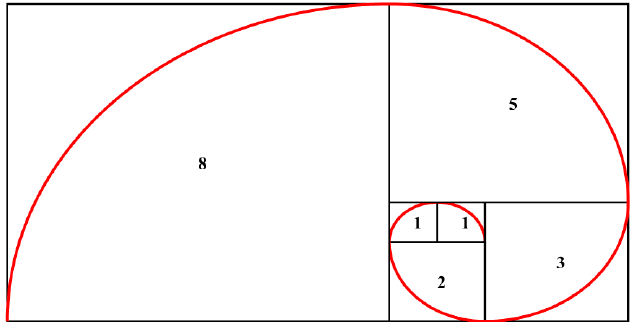
Figure 1. Archimedean spiral (not to scale) function with the set of parametric equations.